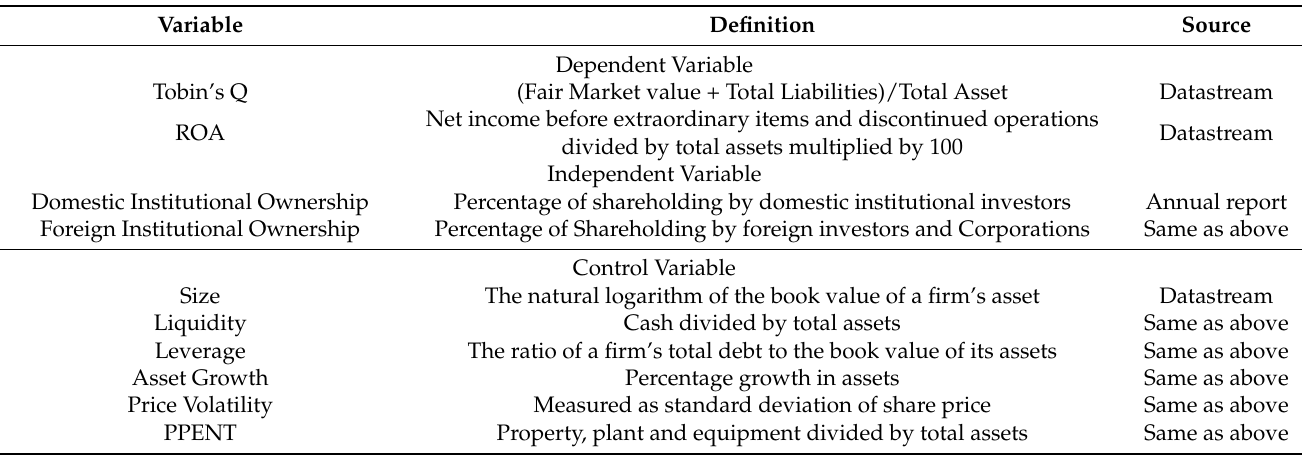
Table 1. Definitions of